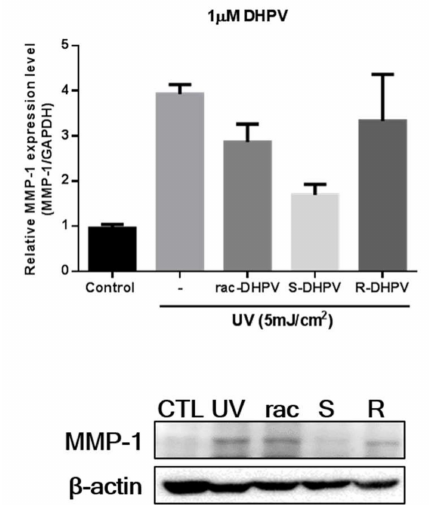
Figure 3. Suppressive activities of the racemic and optically pure DHPVs against UV-induced MMP-1 expression assessed by quantitative real-time PCR ( top ) and western blot analysis ( bottom